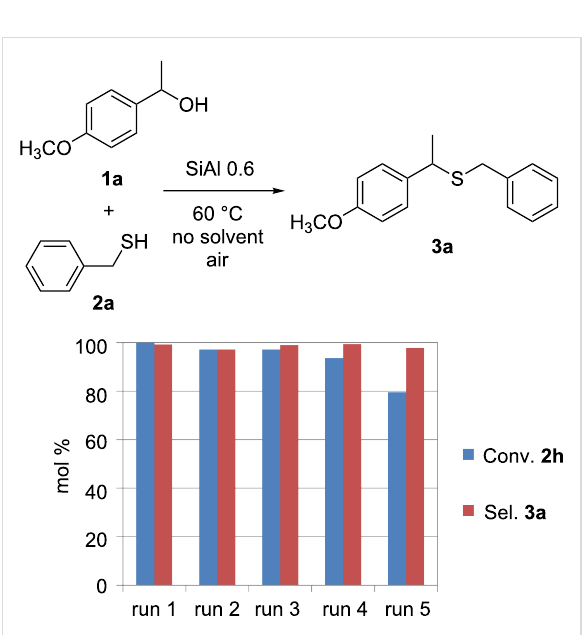
Figure 6: Recyclability test of SiAl 0.6 catalyst in the reaction of 1a and 2a